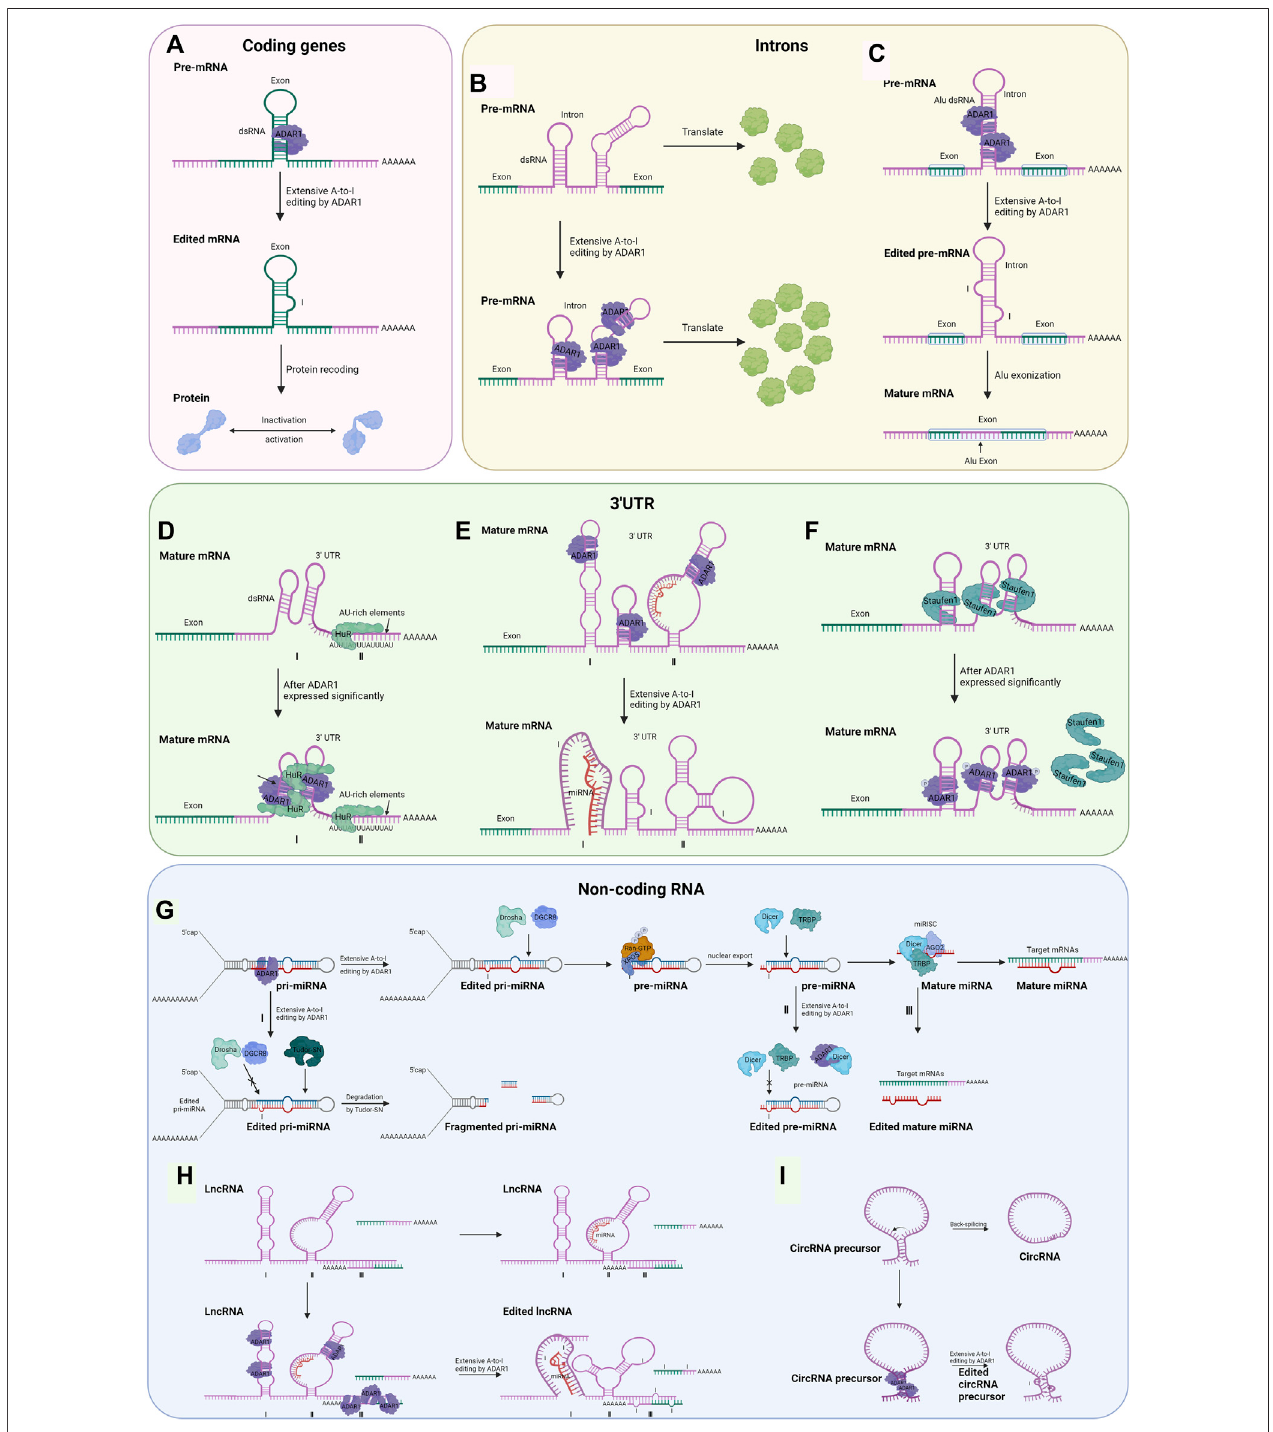
FIGURE 2 | Possible regulatory mechanisms for RNA editing-dependent and editing-independent of ADAR1 involved in tumorigenesis and progression (Created with BioRender.com). (A) The dsRNA hairpin structures formed in the exonic region of the encoded gene are recognized by ADAR1. It undergoes A-to-I editing, and splicing machinery interprets inosine as guanosine, which leads to inactivation or activation of the fi nal translation product. (B) ADAR1 binds to the intron of pre-mRNA, resulting in increased abundance of exon. (C) By editing intronic fold-back dsRNAs with A-to-I editing, splice sites could be created or deleted, leading to the inclusion or exclusion of Alu exons. (D) ADAR1 interacts with HuR proteins to coregulate common transcripts. (E) Editing of the 3 ′ UTR can change the stability of the mRNA by creating or destroying the binding site of the miRNA. Ⅰ : acquired the ability to bind miRNA; Ⅱ : loss of the ability to bind miRNA. (F) ADAR1 competes with